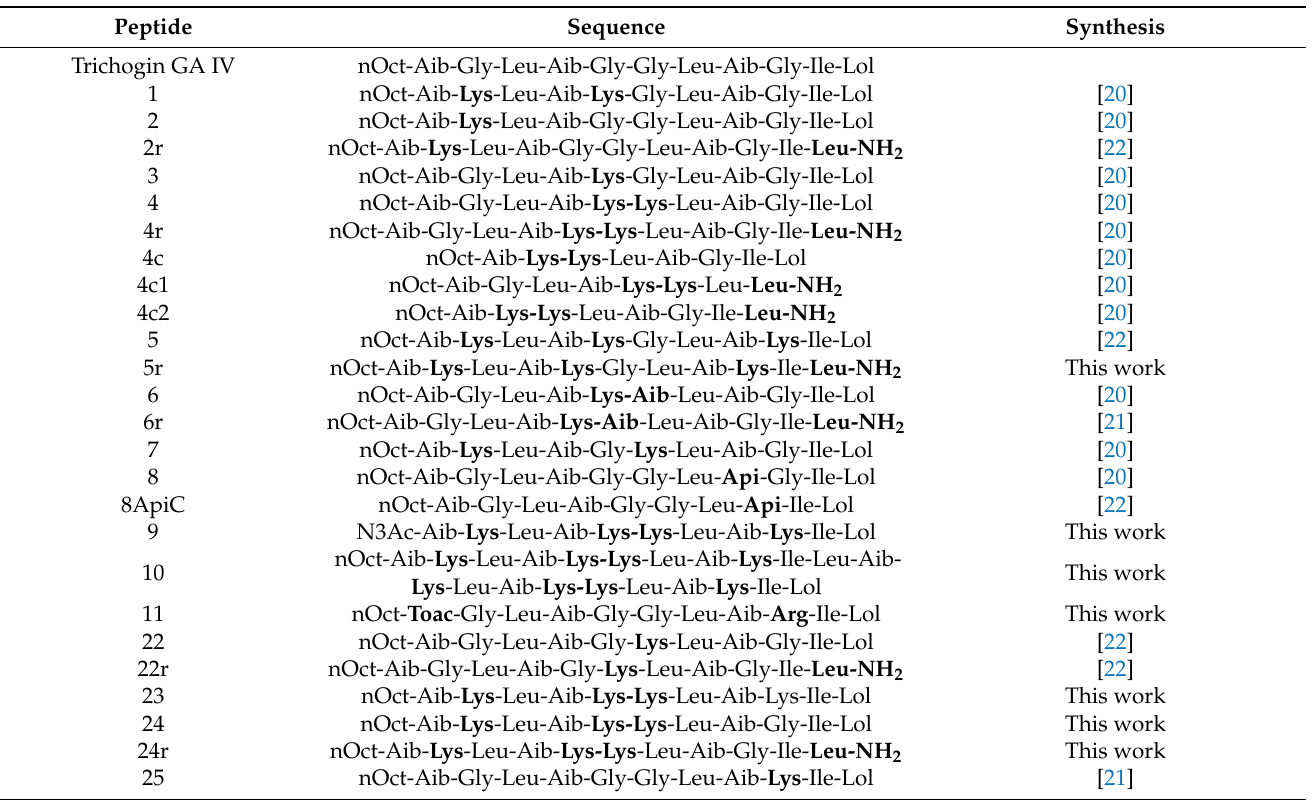
Table 1. Trichogin GA IV analogs used in this